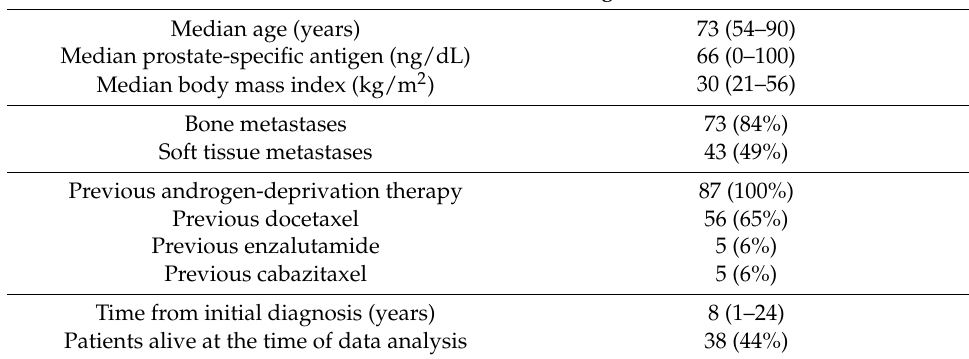
Patient Characteristics at the Time of Initiation of Abiraterone Acetate and Prednisone for